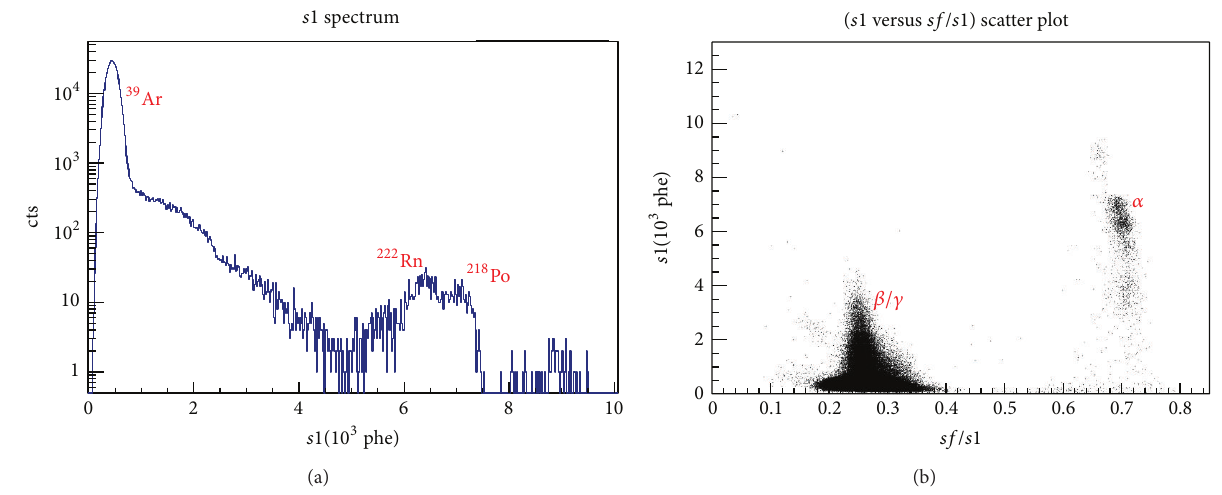
Figure 7: Primary signals collected with the WArP 100l detector in 2011: (a) primary energy spectrum in units of phe. The low energy region is dominated by the 39 Ar 𝛽 -spectrum, then at higher energies signals from other radioactive contaminants are present. The 𝛼 -peaks of 222 Rn and 218 Po are visible at 6-7 × 10 3 phe; (b) ( 𝑠1 versus sf / 𝑠1 ) scatter plot, showing the separation between slow events, induced by 𝛽/𝛾 radiation, and fast ones, mostly due to 𝛼 -decays.